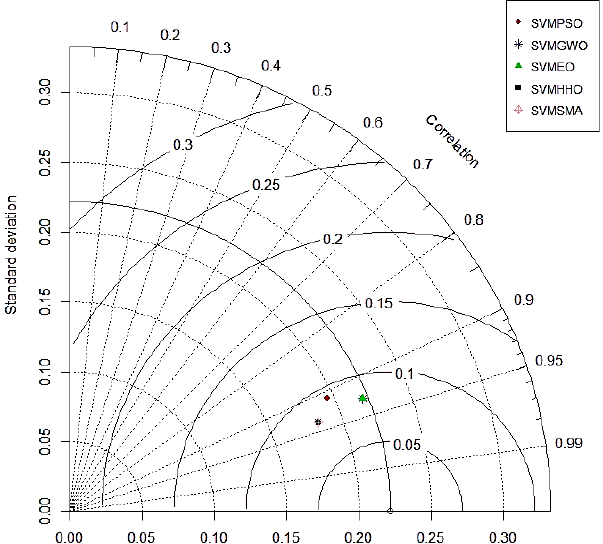
Figure 8. Taylor diagram for the testing results. Table 8. Values of